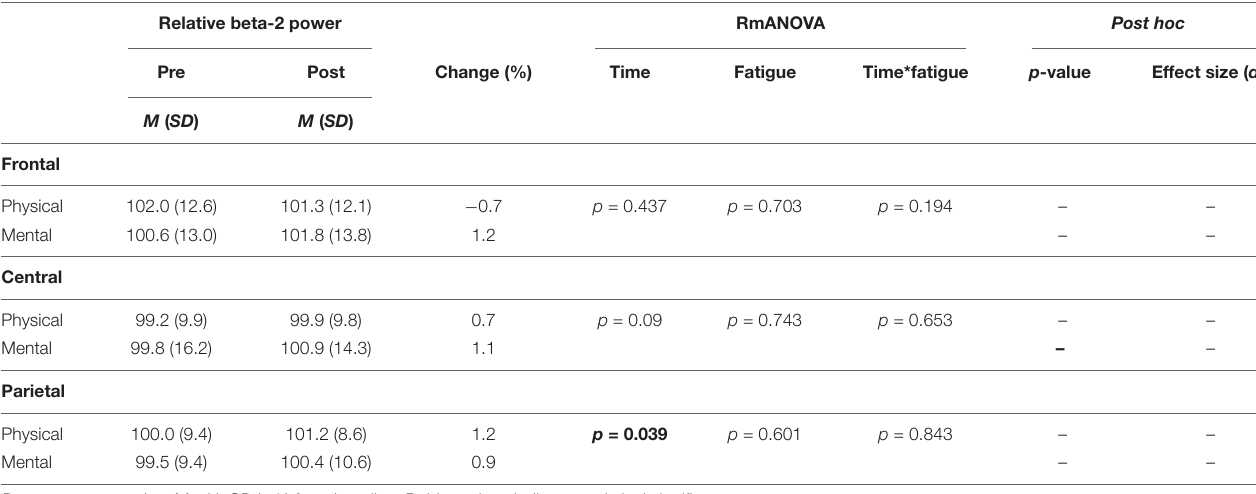
TABLE 6 | Averaged beta-2 frequency power relative to baseline values pre and post to PF and MF within the respective ROIs as well as rmANOVA results and post hoc tests. Relative beta-2